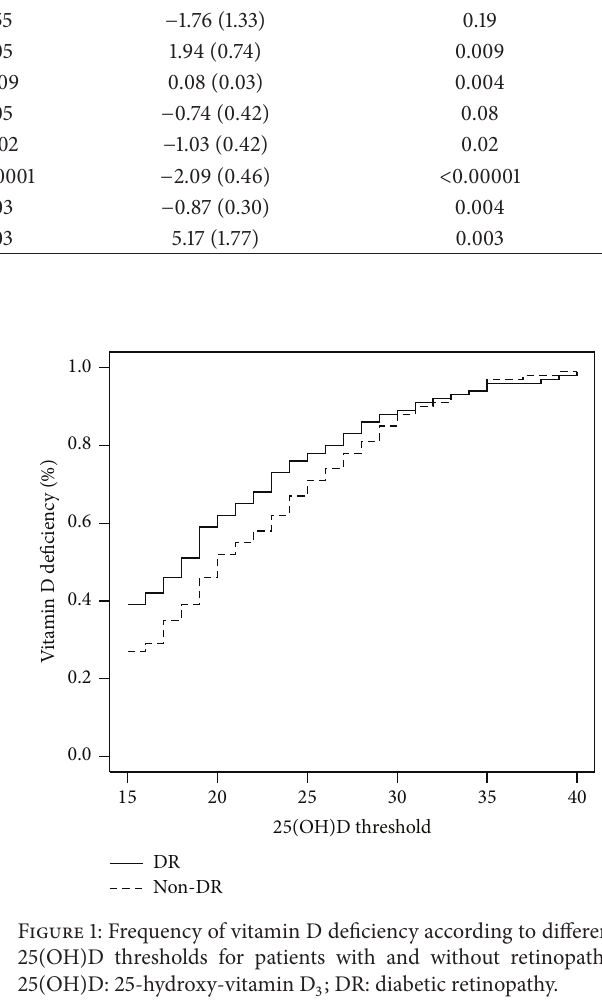
frequencies of vitamin D deficiency that augmented with increasing creatinine concentration tertiles (31.9%, 34.8%, and 46.7%, resp.) in contrast to the frequencies observed in the group of patients without